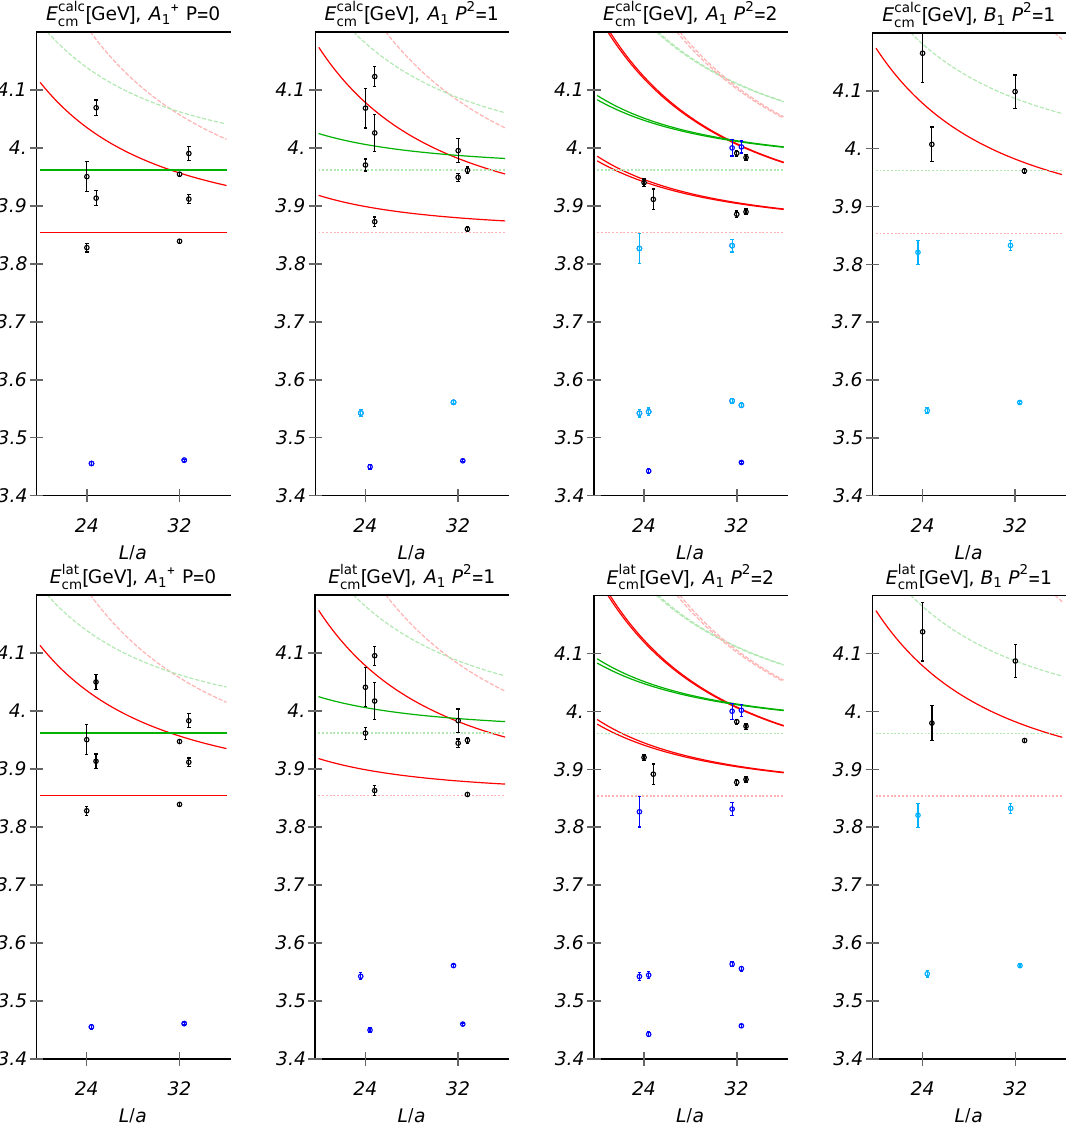
Figure 11 . The lower figures present the original eigen-energies E lat tations considered. The upper figures present the eigen-energies E calc match those in figure 2. The E calc are inputs to our scattering analysis, while E lat are considered to be less reliable input according to the discussion in section